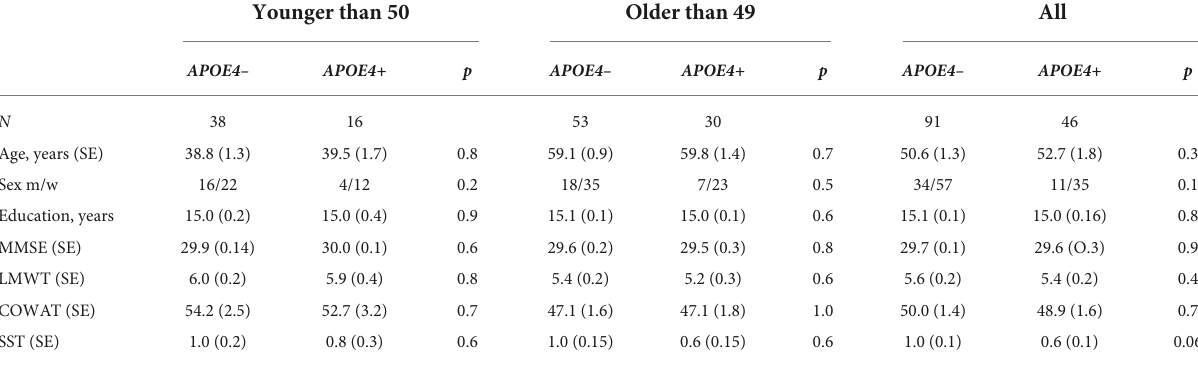
TABLE 1 Demographic and psychometric characteristics of